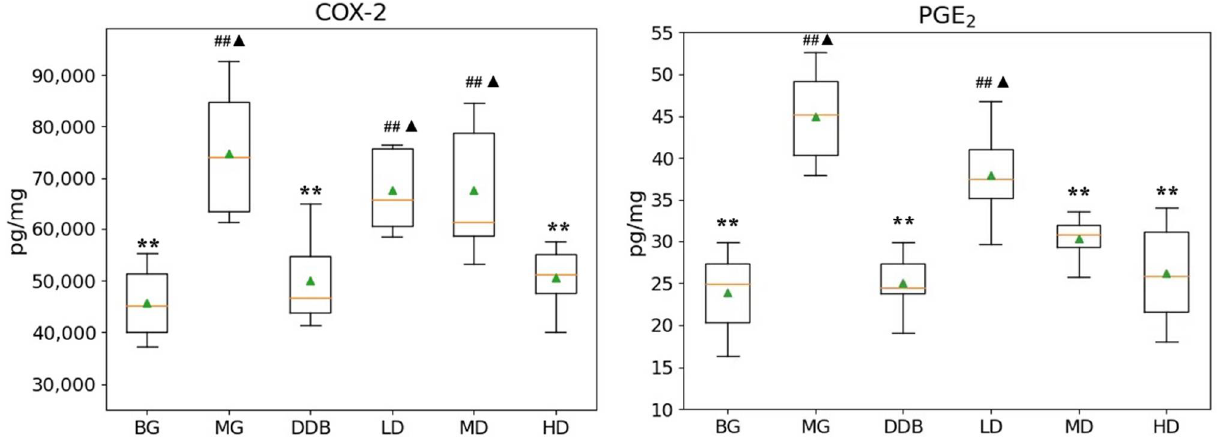
Figure 3. Effects of SBS on COX-2 and PGE2 in liver tissue. Data are presented as mean ± S.E.M. ( n = 10). Significant differences compared with the BG group were designated as ## p < 0.05, with the MG group as ** p < 0.01, and with the DDB groups as ▲ p < 0.05.